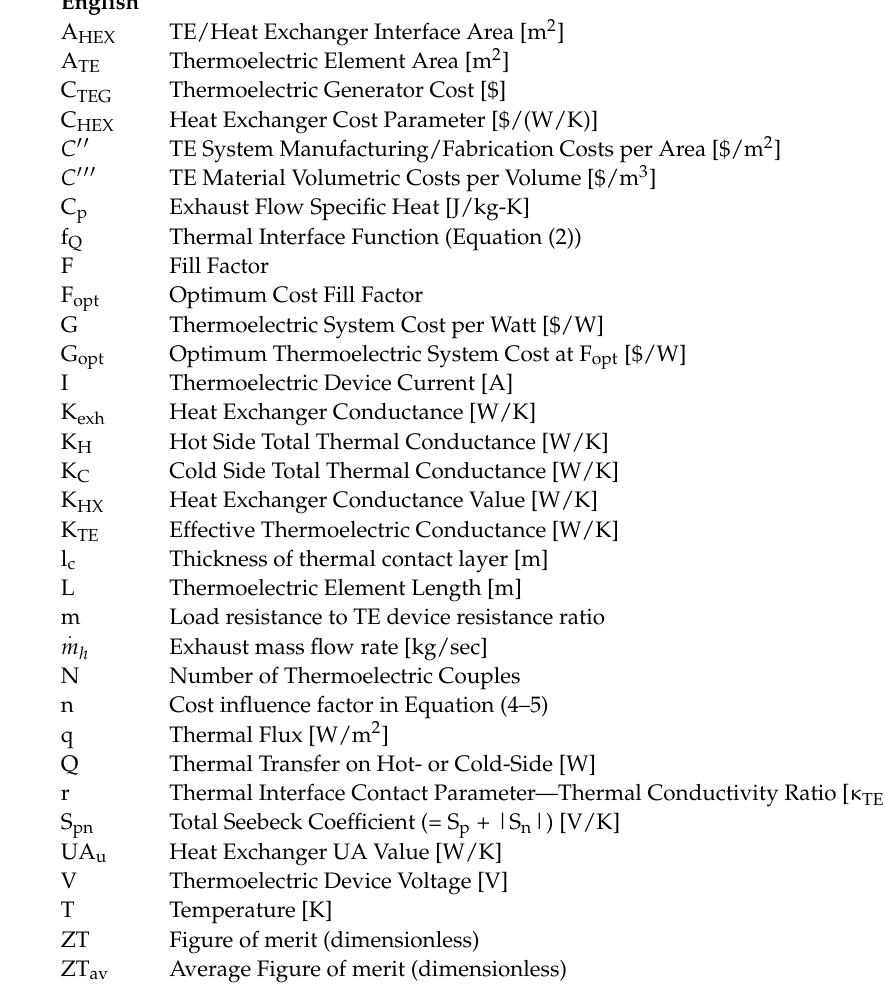
Figure of merit (dimensionless) Average